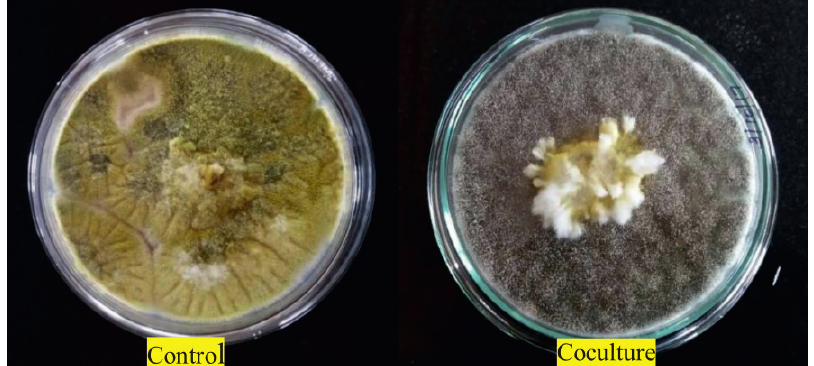
Fig. 1. Control plate shows axenic culture of A. flavus whereas in coculture, mycelial growth of pathogenic A. flavus is surrounded by the mycelia of A. giganteus . The interaction between the fungi was ranked as Class 1 based on Bell’s Ranking scale as A. giganteus showed massive overgrowth over the